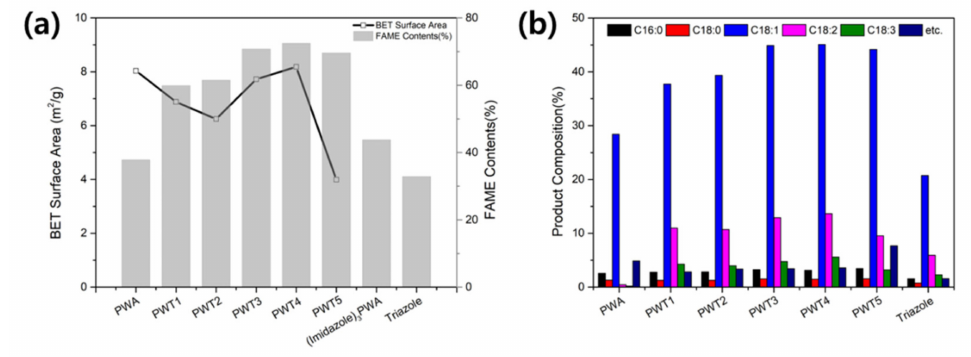
Figure 6. ( a ) FAME contents of the transesterification of rapeseed oil showing the BET surface areas and ( b ) the selected product compositions (C16:0, C18:0, C18:1, C18:2,